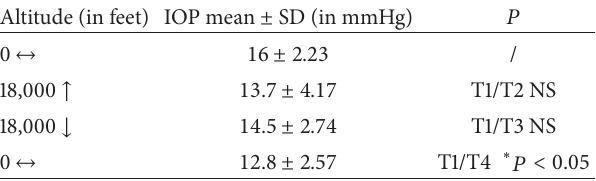
Table 1: Values of mean intraocular pressure (IOP) recorded at T1 (baseline phase to sea level), T2 (ascent phase to 18,000 feet), T3 (descent phase to 18,000 feet), and T4 (return phase to sea level). Altitude (in feet) IOP mean ± SD (in mmHg) 𝑃 0